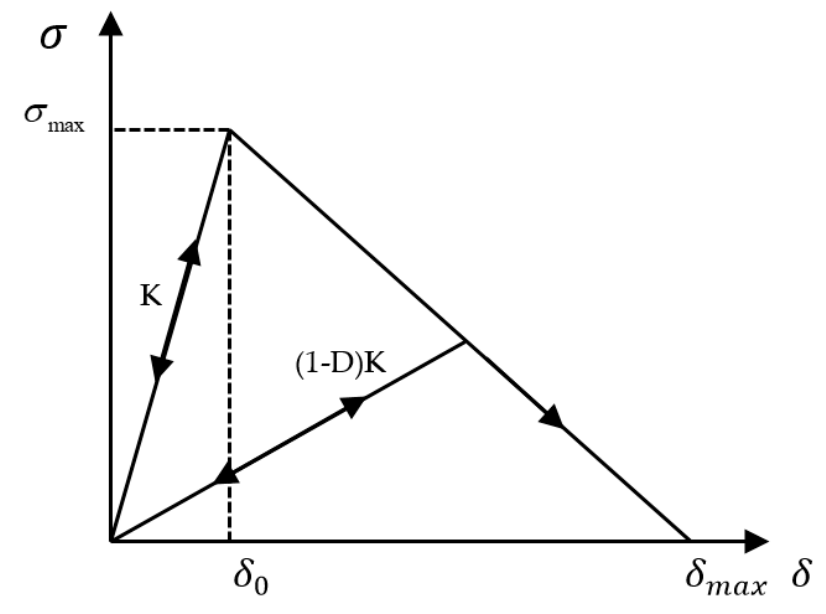
Figure 3. Bilinear constitutive model of the cohesive element.